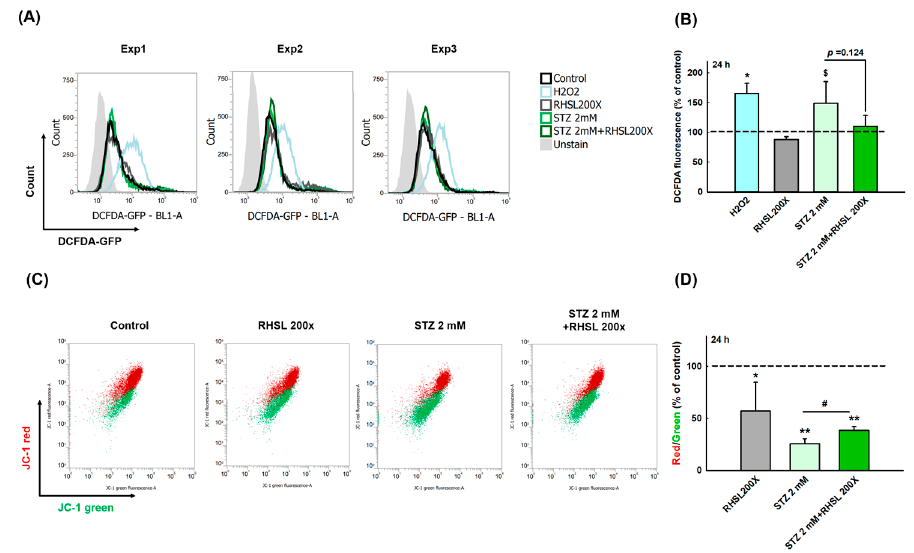
Figure 2. RHSL protects RIN-m5F cells against STZ-induced oxidant damage. Following treatment with RHSL in the absence or presence of STZ (2 mM) for 24 h. ( A ) The image of DCFDA fluorescence showed typical results of three independent experiments. ( B ) The DCFDA fluorescence intensity ratio represents the level of ROS production in RIN-m5F cells, and the dotted line represents the control group. ( C ) Distribution dot plot of mitochondrial depolarization stained by JC-1 ( D ) The red (~590 nm)/green (~529 nm) fluorescence intensity ratio represents depolarization of the mitochondrial membrane in RIN-m5F cells, and the dotted line represents the control group. $ p = 0.066; * p < 0.05; ** p < 0.001 compare with control group (citrate acid); # p < 0.05 compare with STZ